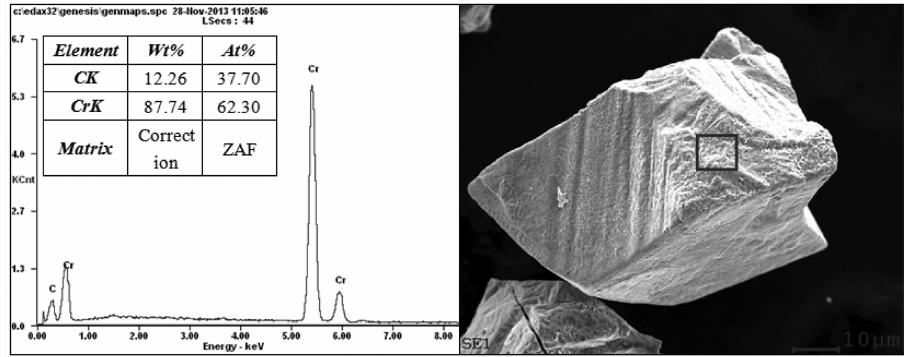
Figure 5: The EDS of coated diamond by microwave heating at the temperature of 850 ° C for